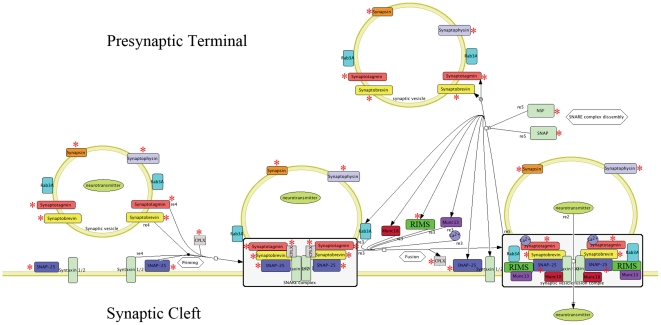
Schematic showing the organisation and synaptic location of SNARE complexs and their associated proteins involved in synaptic vesicle docking.The SNARE associated proteins encoded by 12 genes shown here to have significantly altered expression in schizophrenia are highlighted by red asterisks and include SNAP25, synaptobrevin encoded by VAMP1, complexins encoded by CPLX1 and CPLX2, synaptotagmins encoded by SYT1, SYT2, and SYT3, synapsins encoded by SYN2, synaptophysin encoded by SYP, RIMS3, NSF, and SNAP encoded by NAPA. This shows the potential for dysregulation of synaptic vesicle docking and neurotransmitter release in the STG in schizophrenia. This figure is adapted from PANTHER pathway p05734 synaptic vesicle trafficking (http://www.pantherdb.org/).